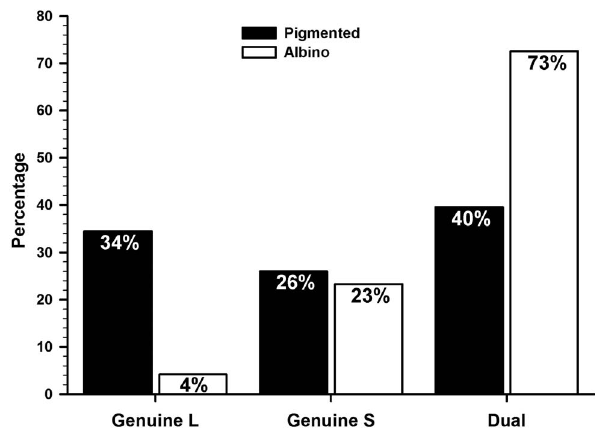
Figure 3. Percentage of genuine and dual cones in albino and pigmented mice. Graph showing the percentage of genuine-L, genuine-S and dual cones in both strains. Percentages were calculated based on data from table 2 and considering 100% the total number of cones (Table 1, all-cones -both opsins-).